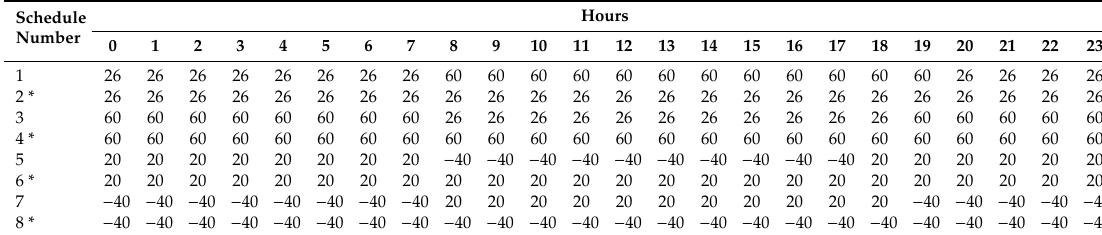
Table 4. Temperature control points of the air